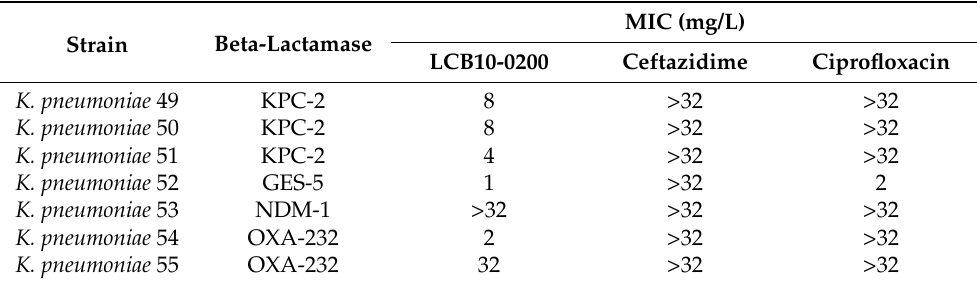
Table 2. Comparative in vitro activities of LCB10-0200 against Klebsiella pneumoniae producing beta- lactamases. MIC (mg/L) Strain Beta-Lactamase LCB10-0200 Ceftazidime Ciprofloxacin